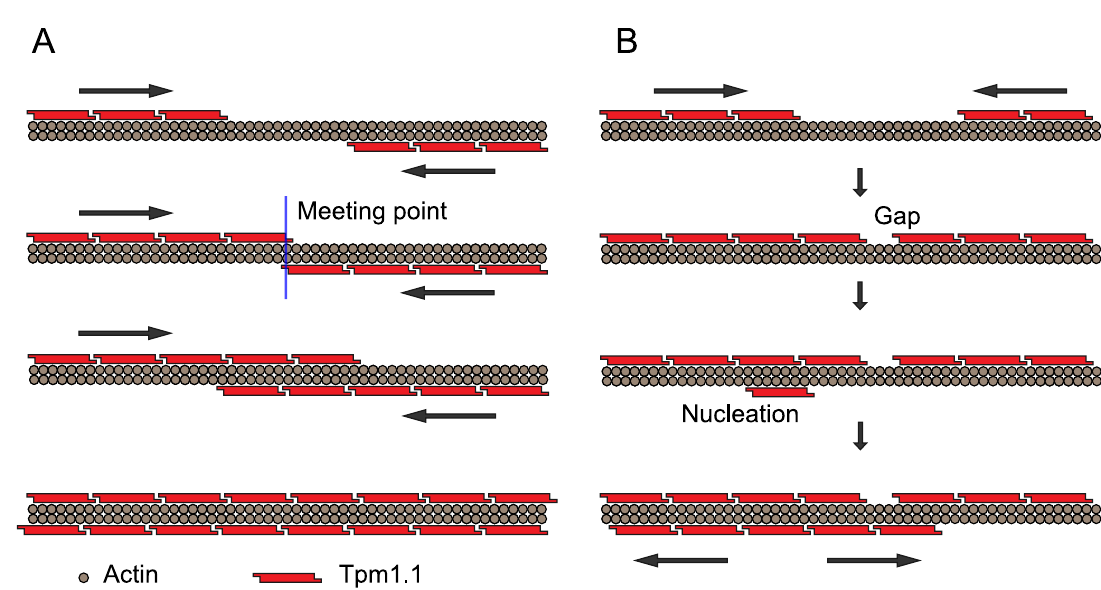
Fig 1. Schematic of Tpm1.1 binding to both sides of actin filament. (A) Growth of Tpm1.1 strands on both sides on actin filament in opposite directions. The meeting point where two intensities of fluorescently labelled Tpm1.1 start to overlap is indicated with the blue line. This type of Tpm1.1 association with actin leads to fully saturated filament. (B) Initial growth of Tpm1.1 strands on the same side of actin can lead to a gap formation or the fully saturated region. A single Tpm1.1 isomer stretches over seven actin monomers; therefore gaps may be formed by short stretches of undecorated actin filament with a length of 1 to 6 actin monomers.